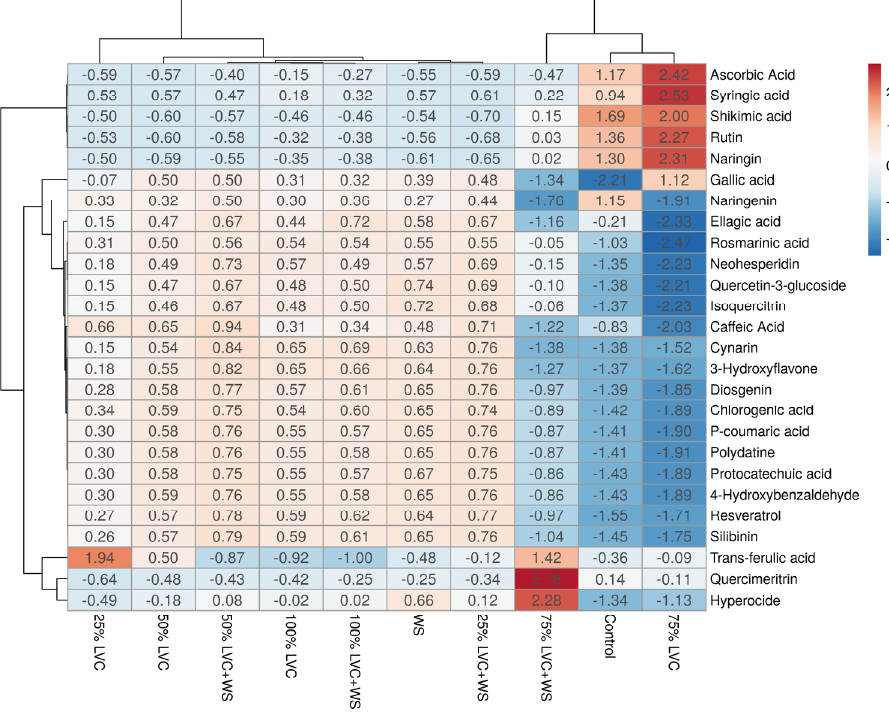
Figure 9. Heat map clustering of phenolics and flavonoids corresponding to the treatments.